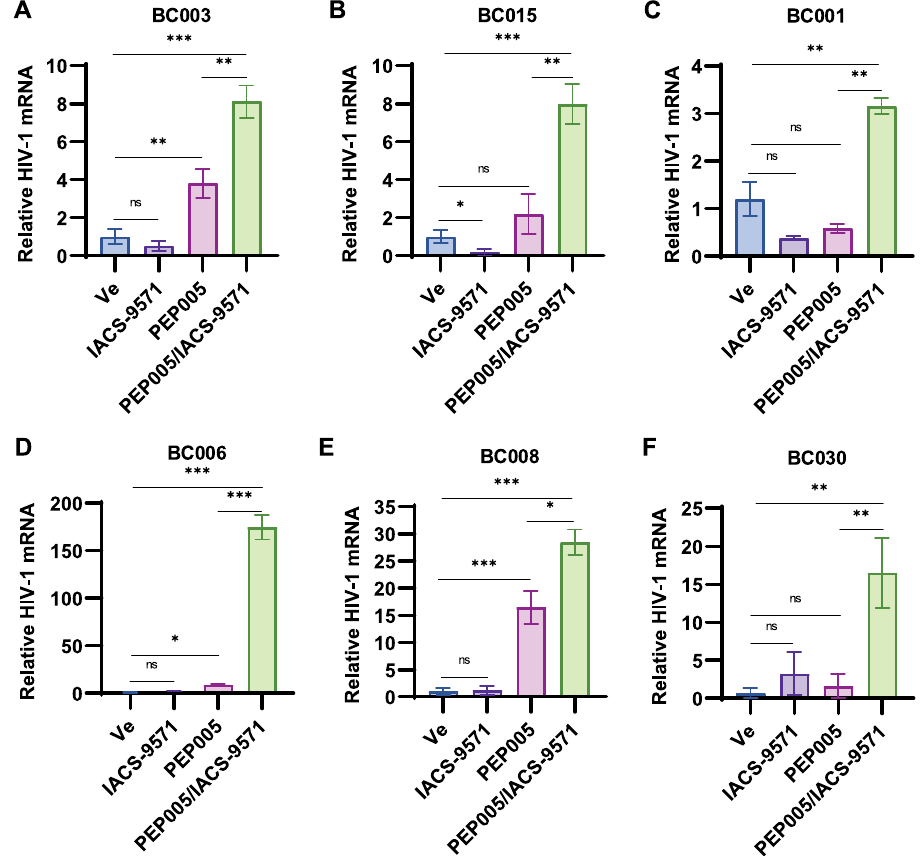
Figure 9. IACS-9571 activates HIV-1 expression synergistically with PEP005 in CD4 + cells from HIV-1 infected individuals. ( A – F ) CD4 + PBMCs isolated from HIV-1 patients on ART were treated with DMSO (Ve), 10 µM IACS-9571, 15 nM PEP005, or with 10 µM IACS-9571 and 15 nM PEP005 for 20 h. Following incubation, intracellular RNA was extracted and subjected to RT-PCR analysis with oligos targeting HIV-1 mRNA. The results of 2 or 3 RT-PCR determinations are displayed with standard deviation depicted as error